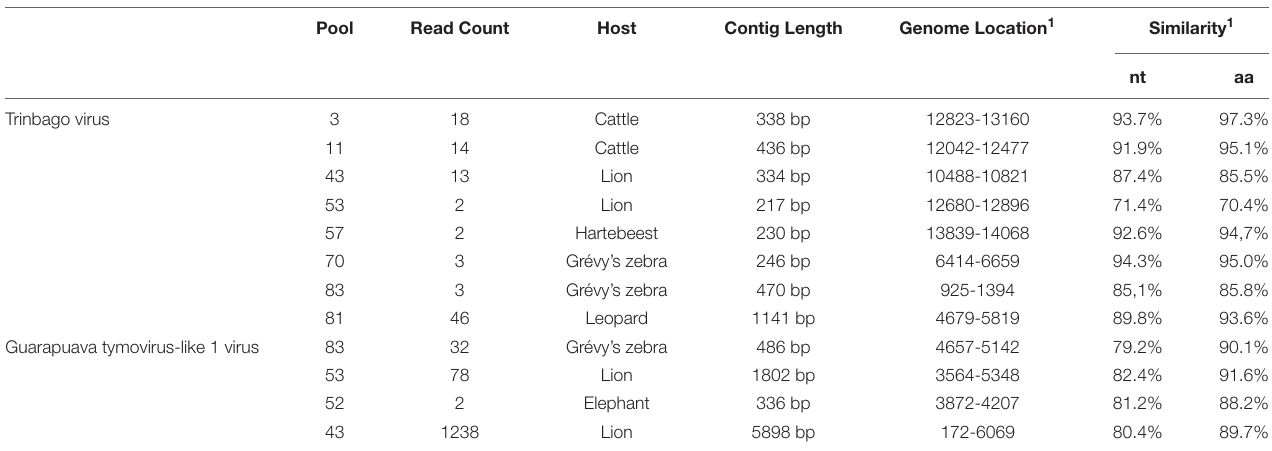
TABLE 3 | Viruses further detected in tick